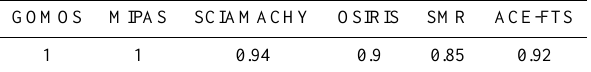
Table 4. The approximate reduction factors for uncertainty esti- mates due to regridding (the reported values of uncertainties should be multiplied with the factor from the